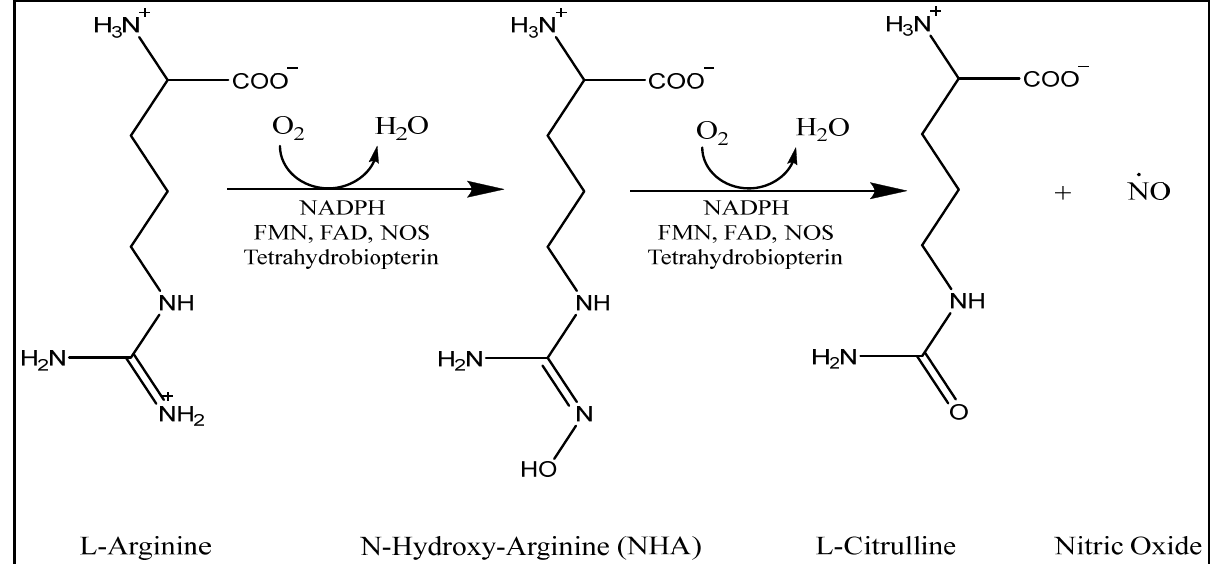
Figure 1. The general two-step catalytic process of NO biosynthesis by all isoforms of NOS enzymes. The first step converts L-arginine to N-hydorxy-arginine. The latter is converted to L-citrulline in the second step with the release of one equivalent of NO.